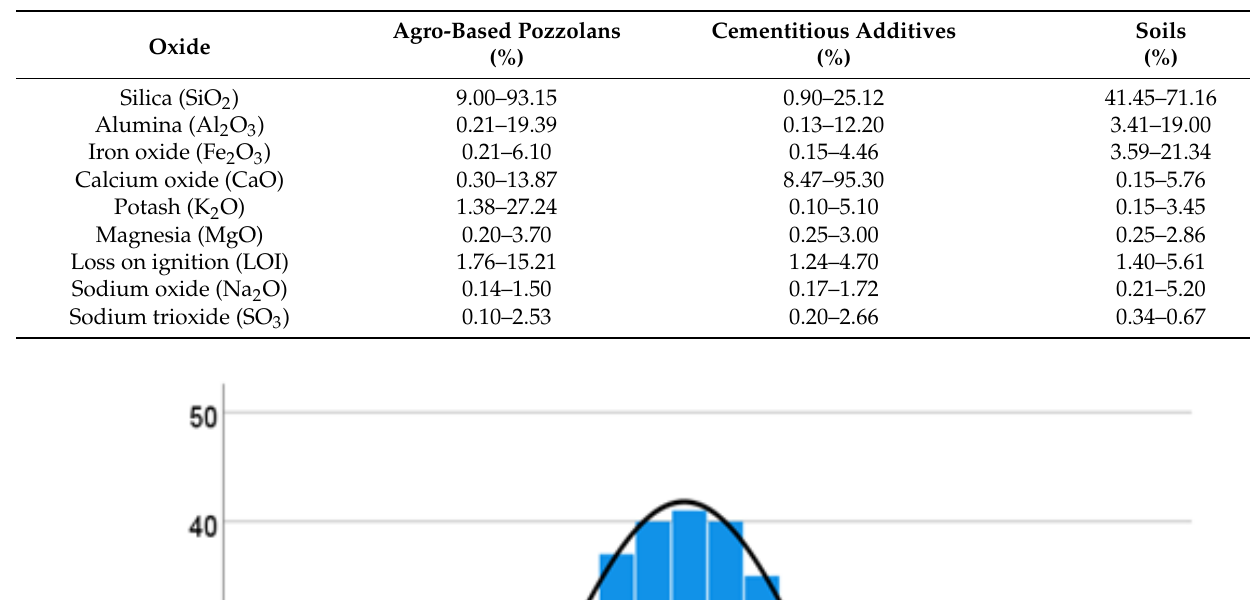
Table 2. Range of chemical compositions of the materials.